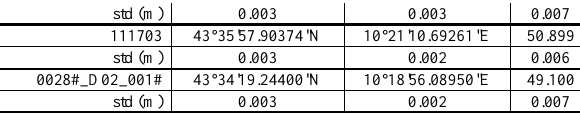
Table 3. Coordinates of the vertices of the IGM network from